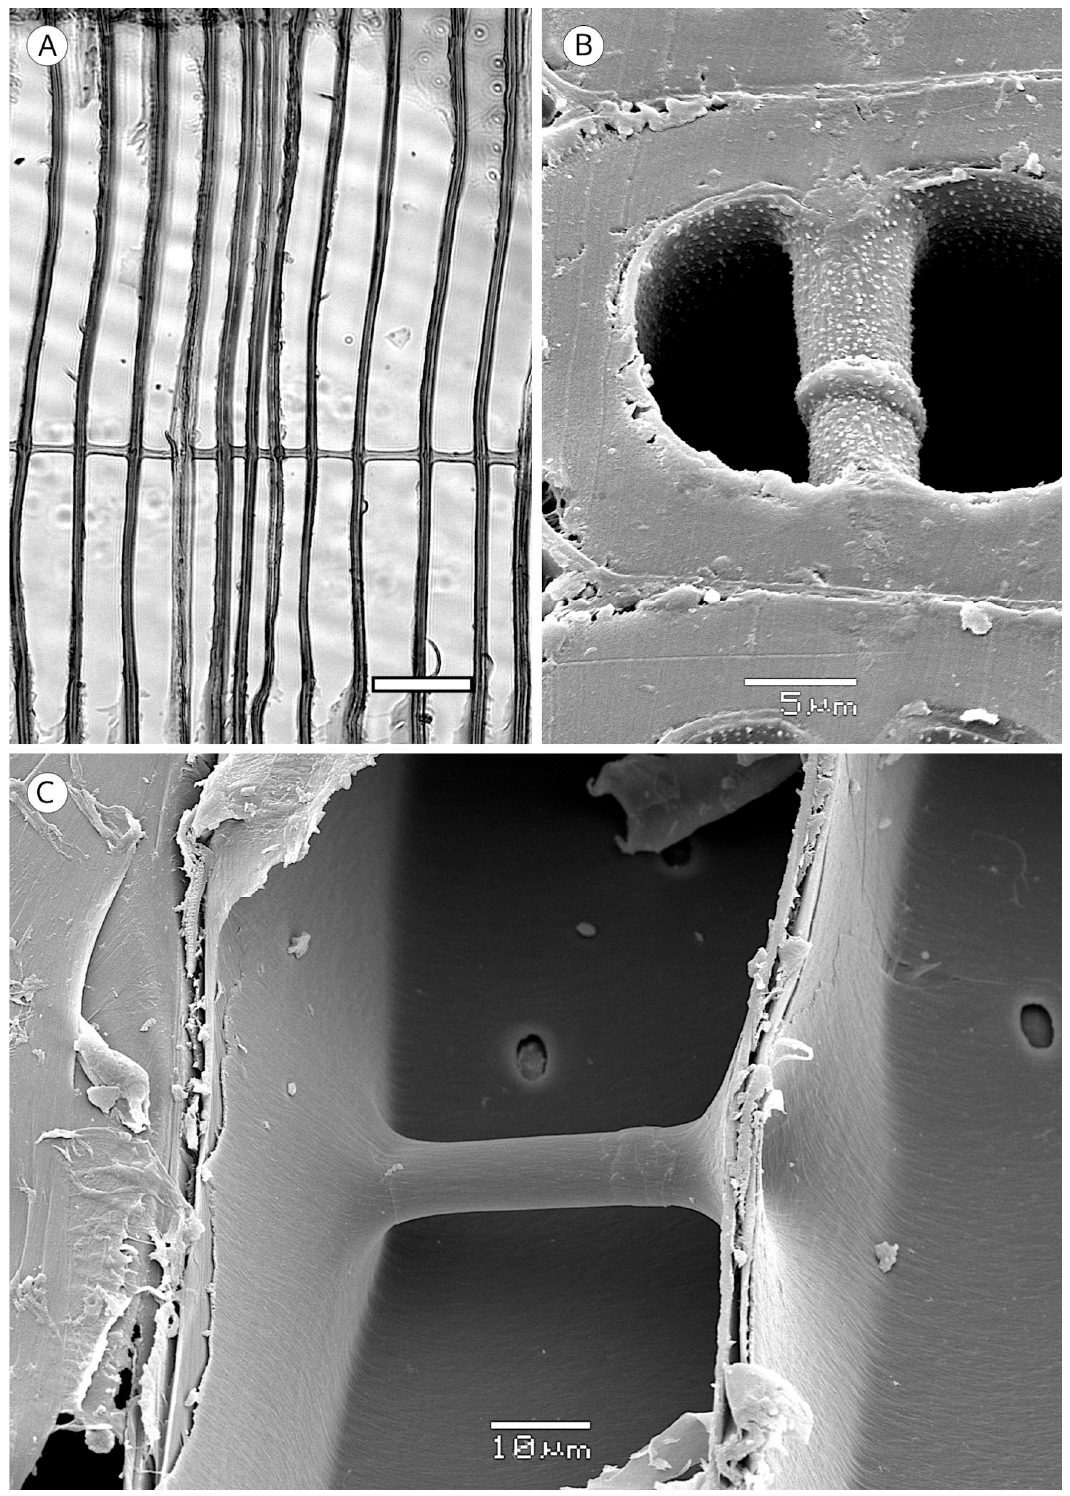
Figure 25. Trabeculae. ( A ) Widdringtonia nodiflora (L.) Powrie; ( B ) Actinostrobus pyramidalis Miq. (SEM); ( C ) Metasequoia glyptostroboides Hu and W.C.Cheng (SEM). Scale bars. ( A ) = 50 μ m. Although Grosser [138] suggested that trabeculae act as bracing elements in tracheids to prevent collapse, this is unlikely in view of the scarcity and irregularity of their presence when they